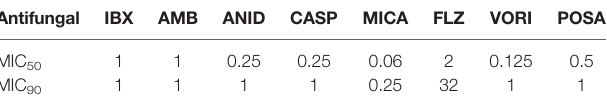
TABLE 1 | MIC values ( m g/ml) of ibrexafungerp and comparators against 72 echinocandin-resistant C. glabrata isolates (Lass-Florl, 2009).